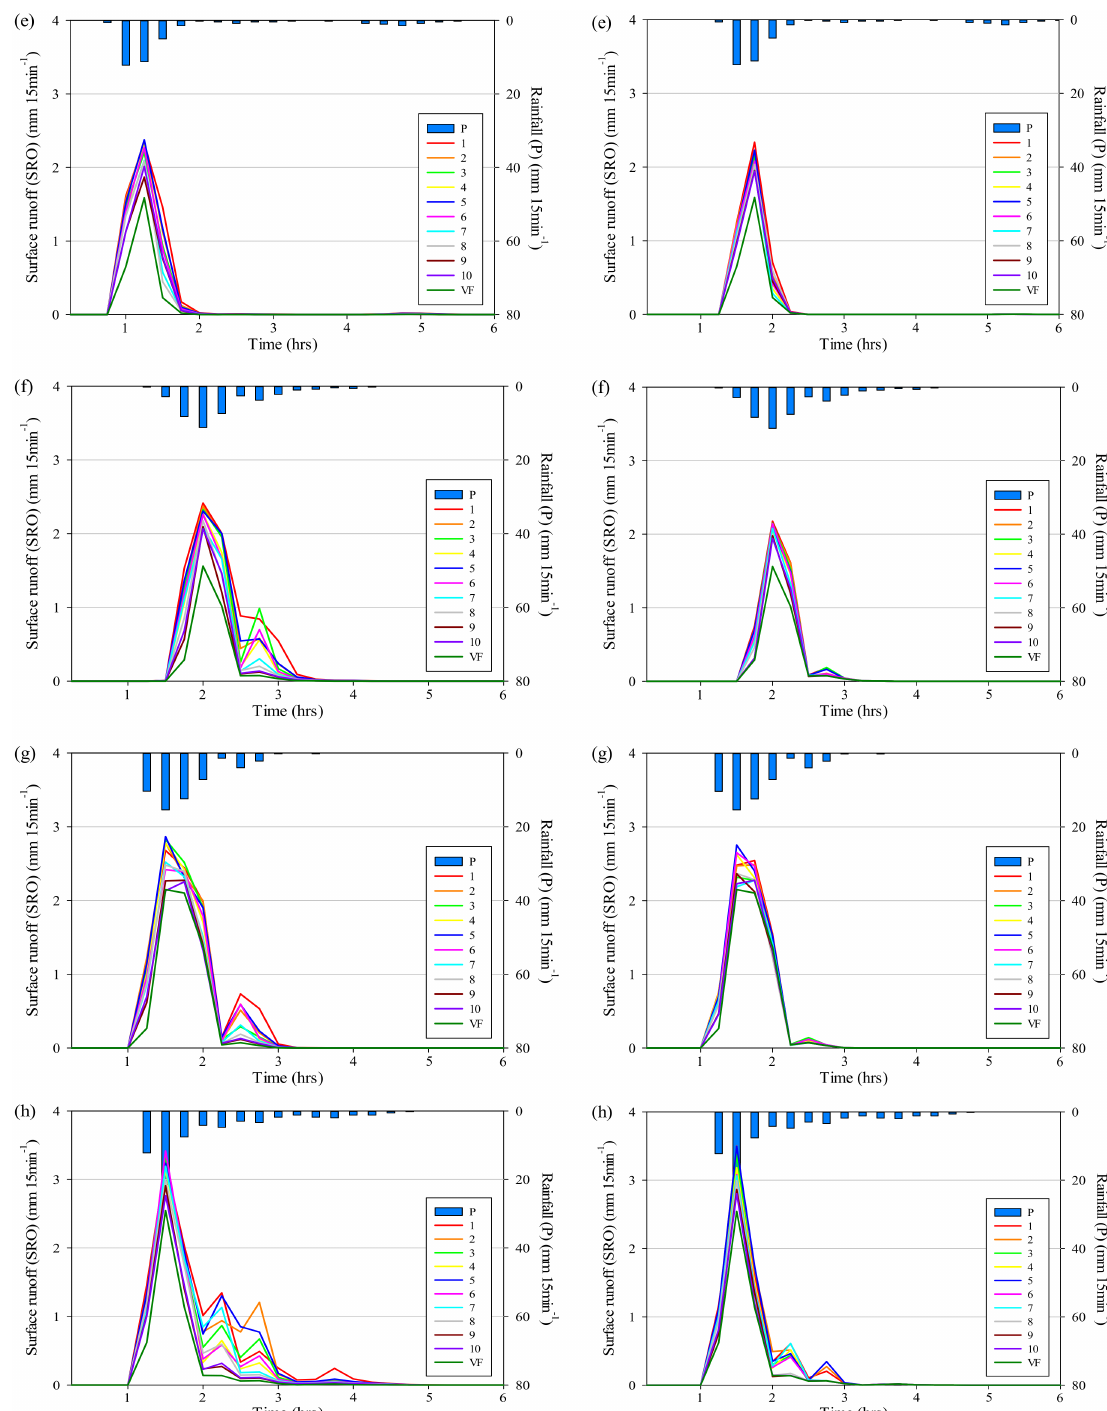
Figure 12. Surface runoff hydrograph generated from rainfall events of: ( a ) 17.8 mm, ( b ) 21.2 mm, ( c ) 27.2 mm, ( d ) 29.2 mm, ( e ) 37.6 mm, ( f ) 41.4 mm, ( g ) 53.4, and ( h ) 66.6